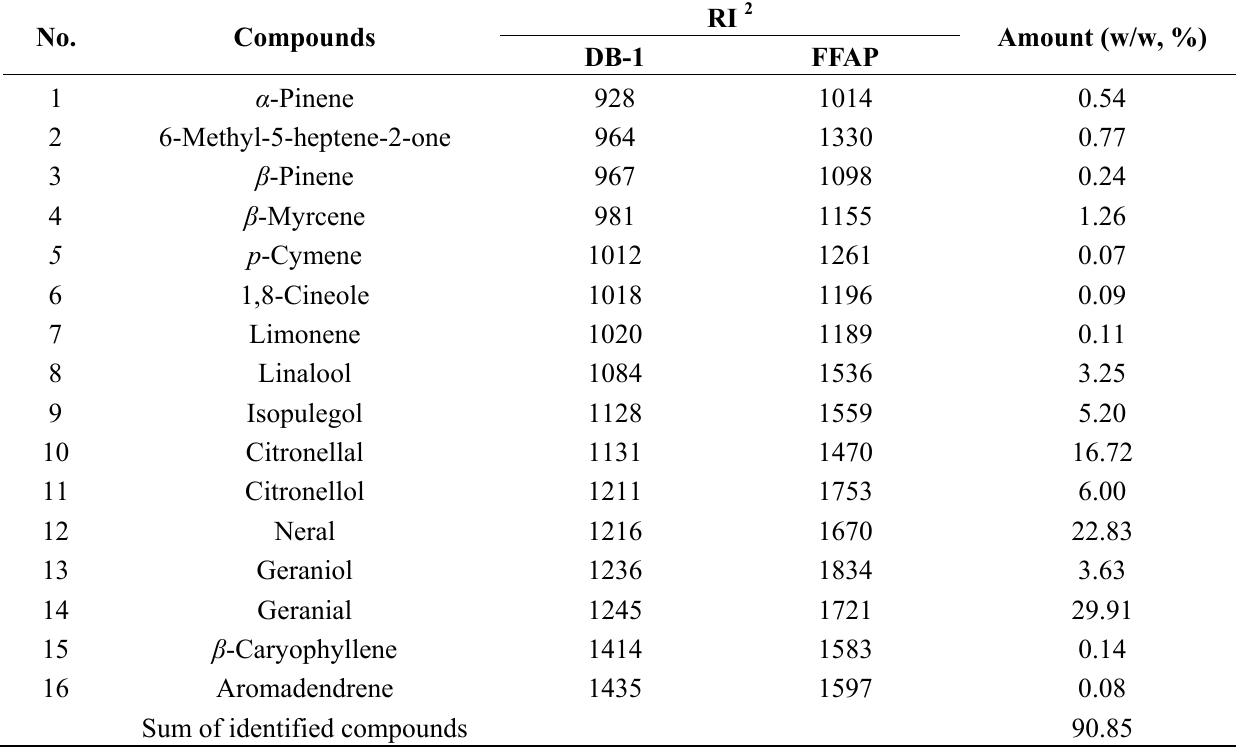
Table 2. Chemical composition of Leptospermum petersonii essential oil 1